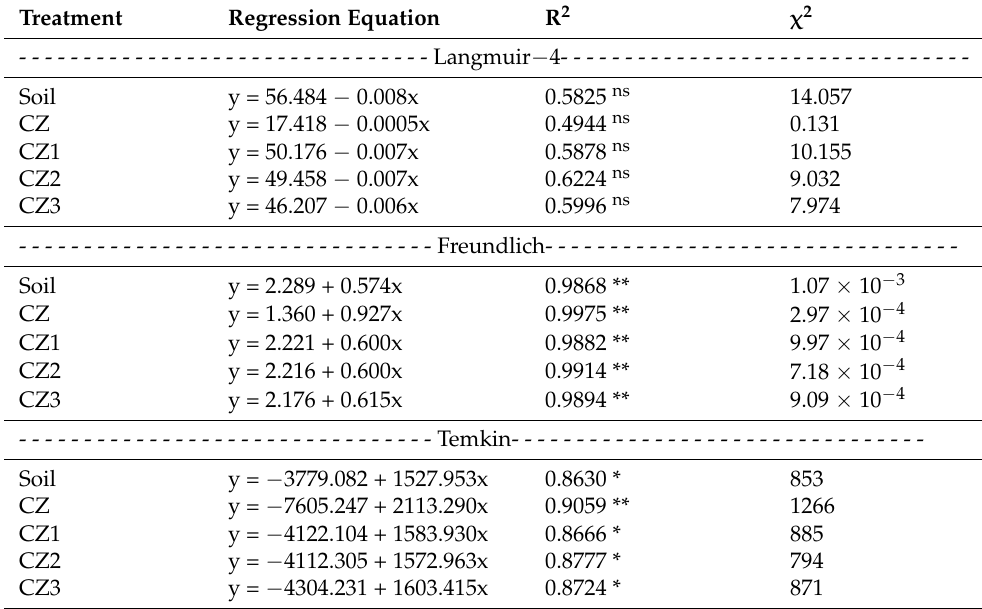
Table 16. Fitting Langmuir type 4, Freundlich, and Temkin isotherms to the phosphorus adsorption data based on simple regression and Chi-square analyses results.